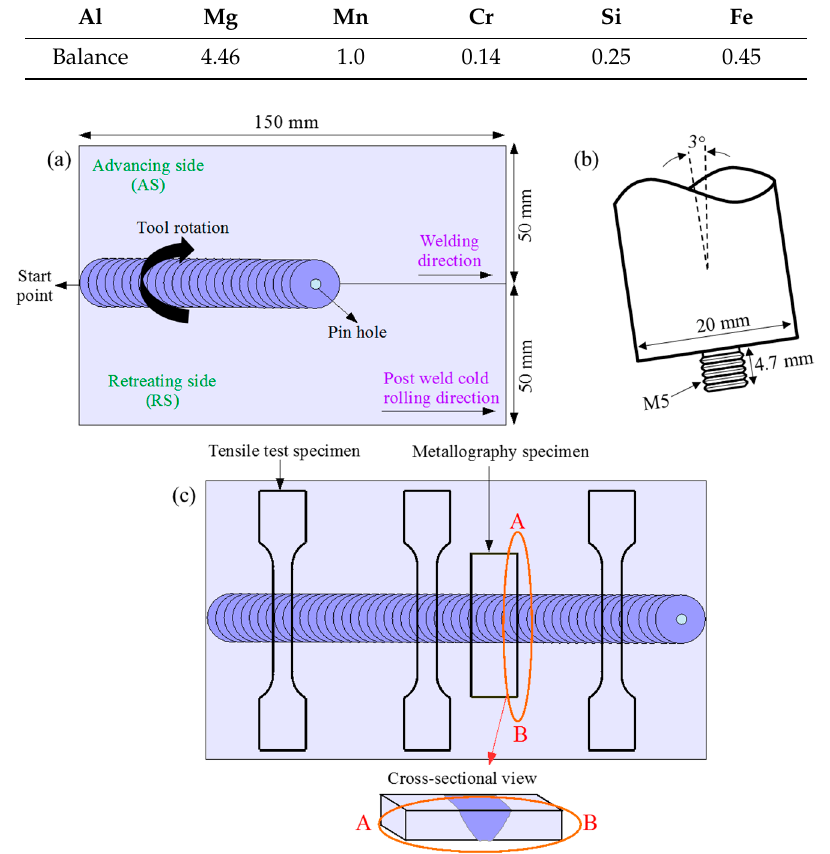
Figure 1. Schematic diagram of the friction stir welding process: ( a ) butt joint configuration, ( b ) tilt angle of the welding tool, and ( c ) location of the machined specimens.